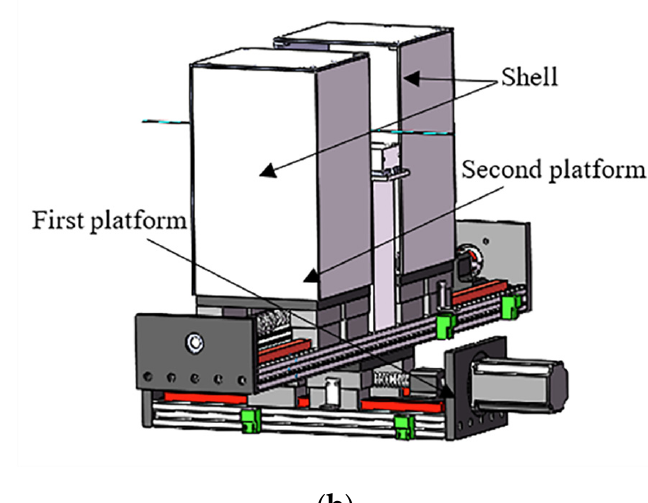
Figure 4. ( a ) Traditional manual operation; ( b ) proposed novel slave manipulator.